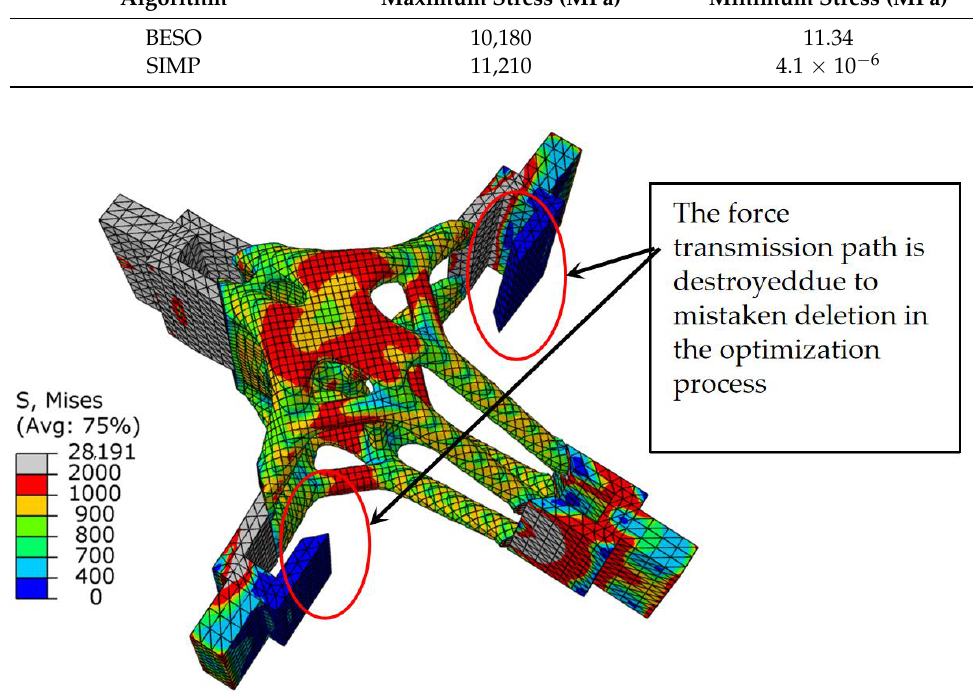
Figure 15. Stress nephogram of SIMP optimization results under shear conditions.